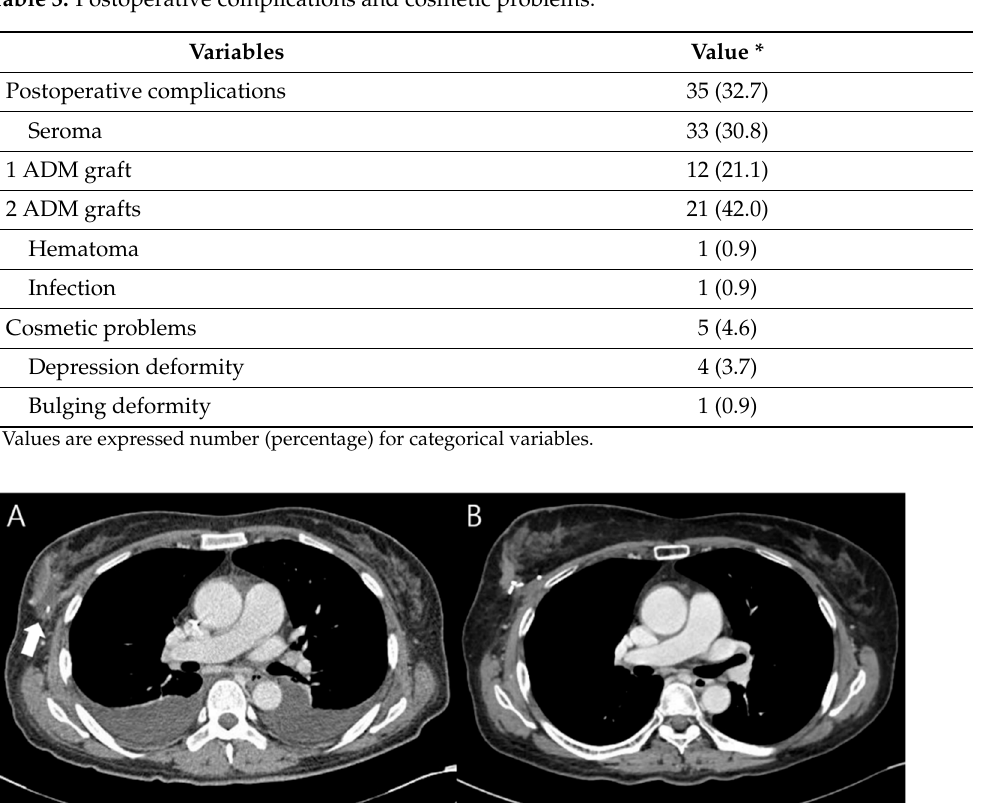
Table 3. Postoperative complications and cosmetic problems.